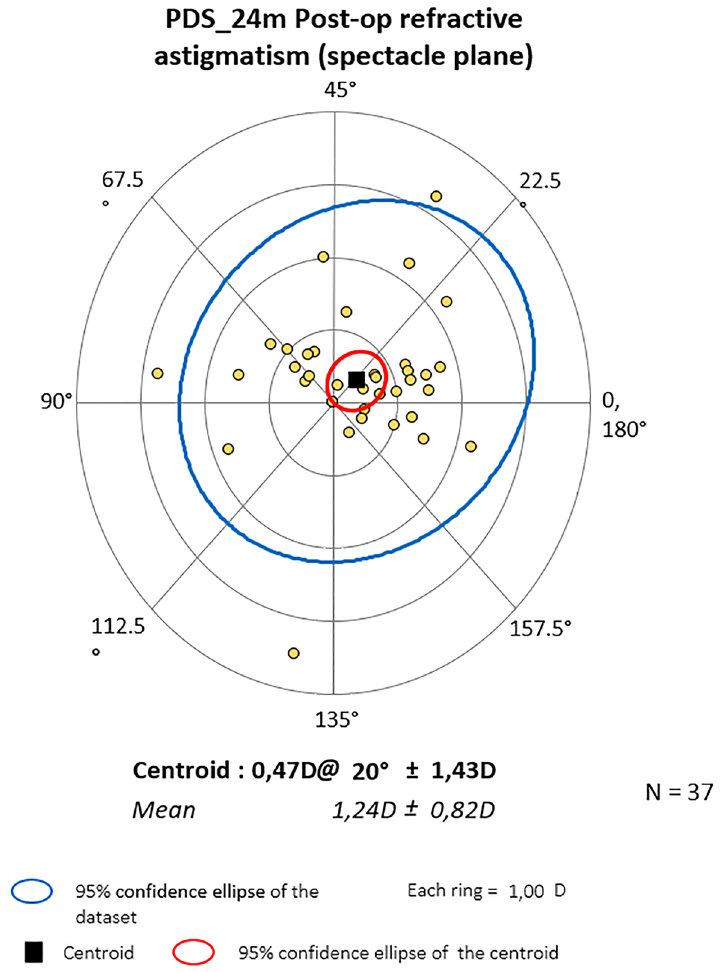
Figure 8. Astigmatism on the double angle plot 24 months post-op in PDS. The trend is ATR. The yellow dots represent a single subject’s